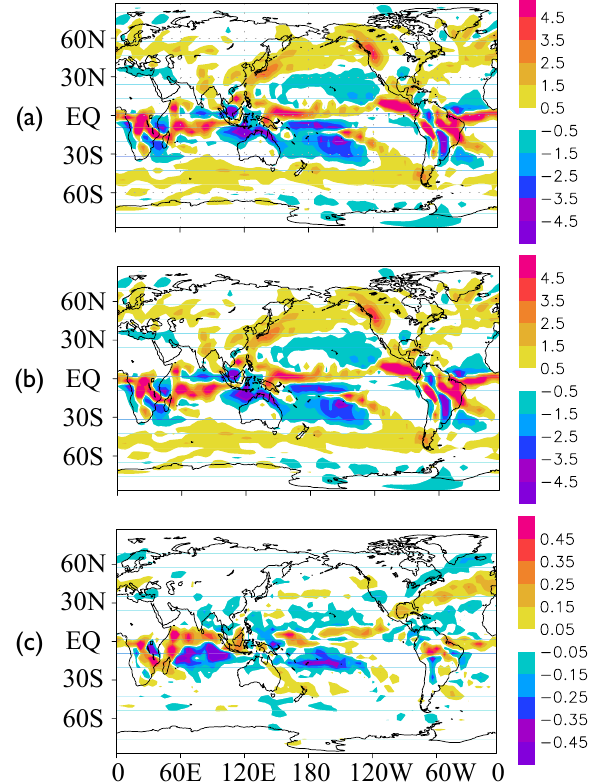
Fig. 2. (a) Spatial distribution the AGCM precipitation error rela- tive to CPC Merged Analysis of Precipitation for RH Conv = 0 . 8 and all other parameters kept to standard values in December–February. (b) Same as above but reconstructed using the quadratic metamodel. (c) Difference between AGCM and metamodel reconstructed error. Note the different color scale in (c) compared to (a) and (b) . Unit: mmday − 1